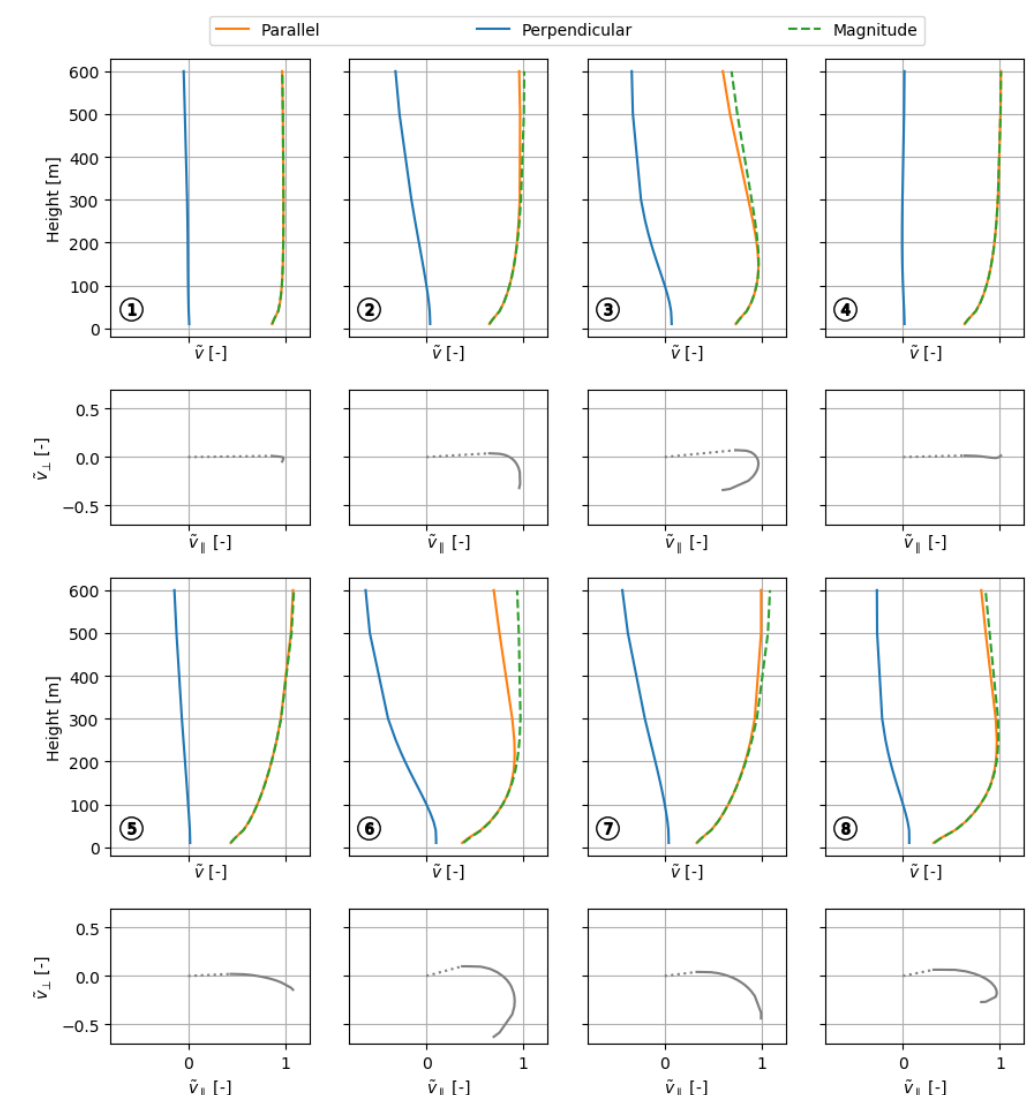
Figure 15. The eight cluster-mean wind profile shapes of the multilocation clusters (ML-1–8). Each shape is depicted by the normalised wind speed components with height (first and third rows) with the corresponding hodograph below (second and fourth rows). In each hodograph, the lower end of the profile is indicated by the dotted line connecting the lowest-height point to the origin. All plots share the same x